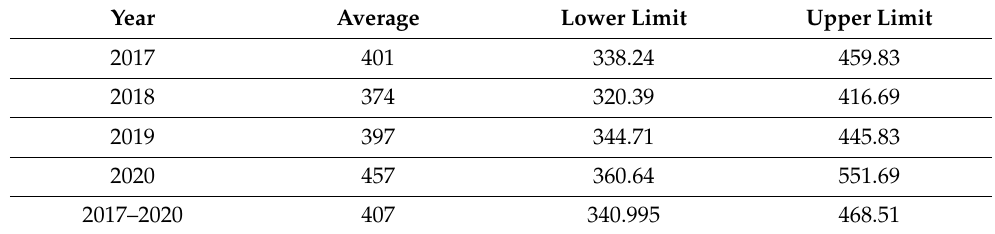
Table 3. Estimated total population numbers of brown bears in Bulgaria for the period